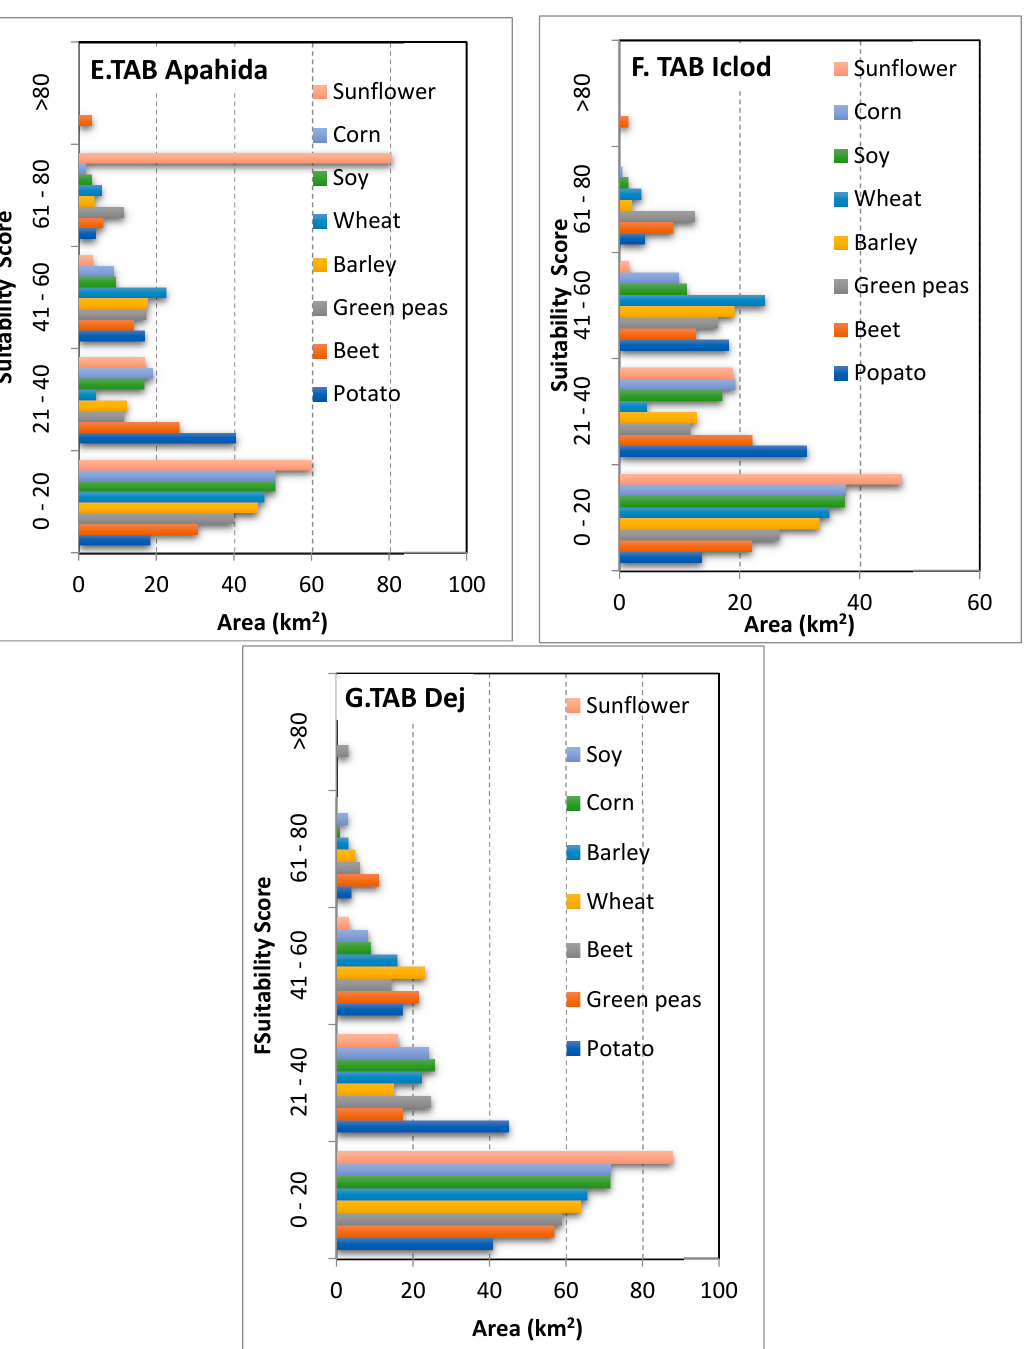
Figure 7. Distribution of suitability classes on administrative-territorial units.